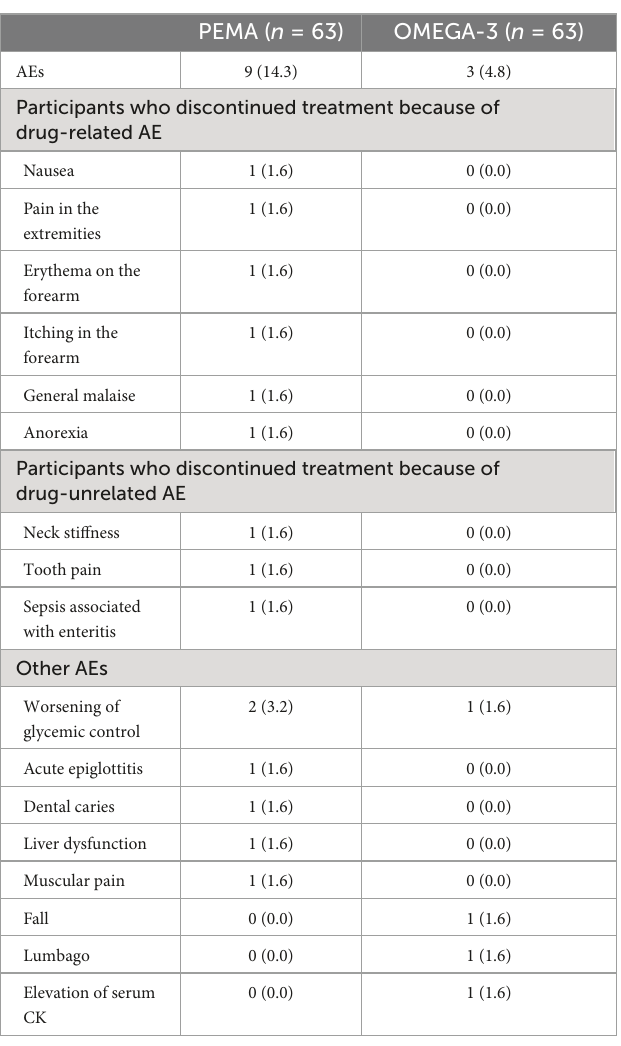
TABLE 6 Adverse